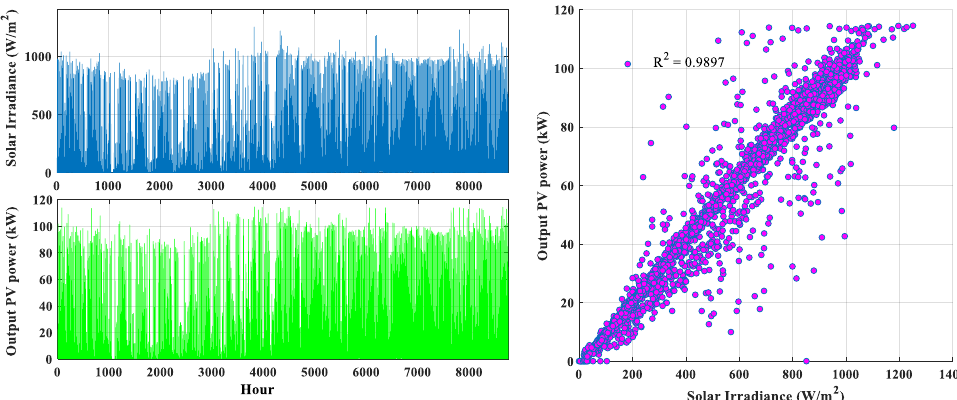
Figure 7. Hourly solar irradiance and the output power of the photovoltaic (PV) array.